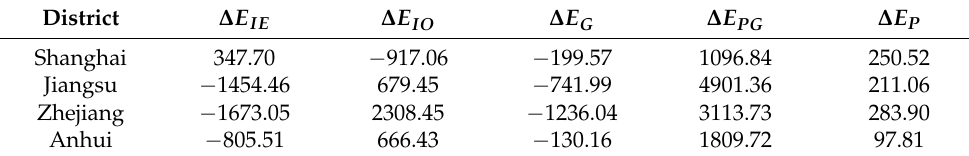
Table 5. Accumulative contribution of influencing factors by four districts (10 8